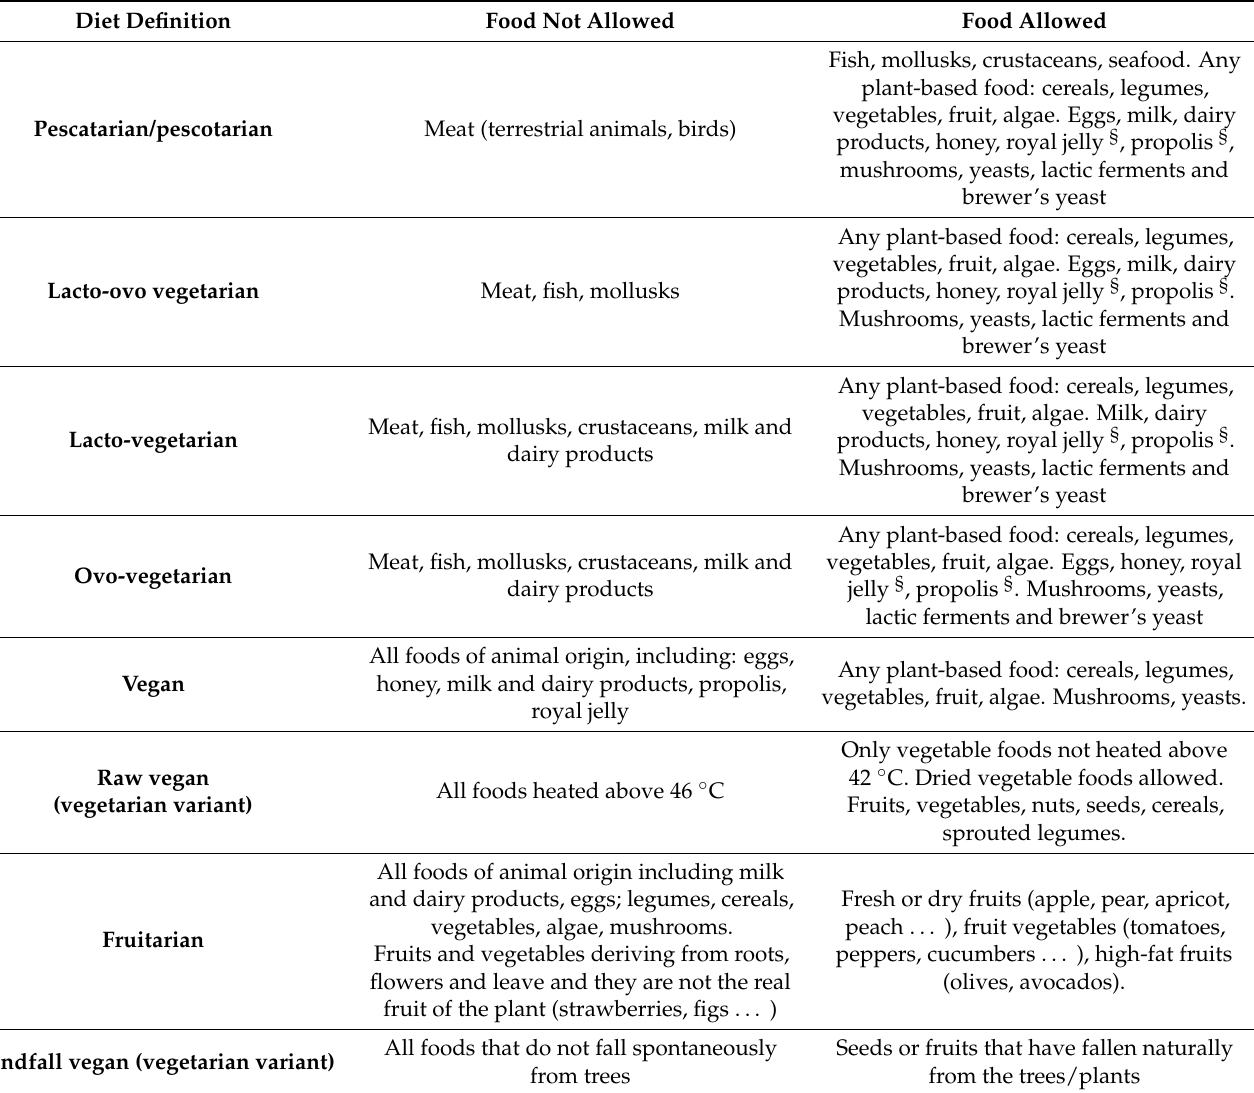
Table 1. Vegetarian-type